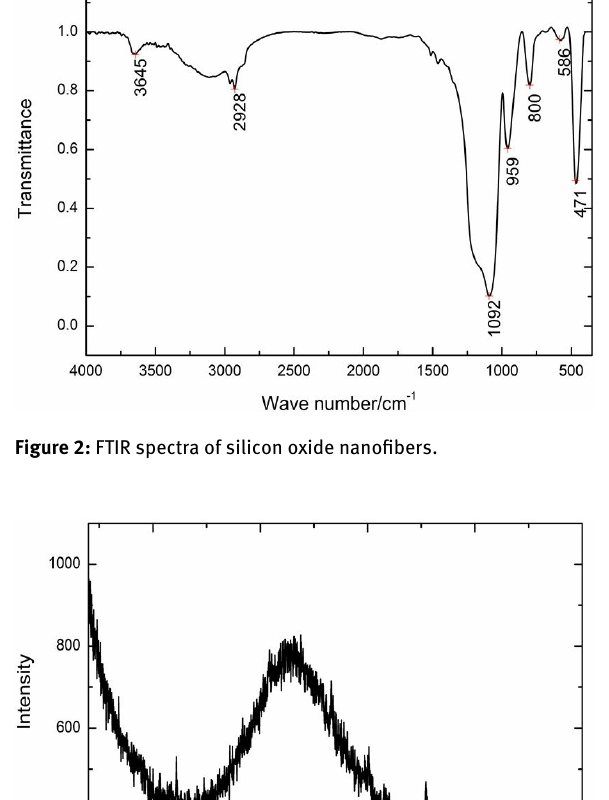
Table 1: Mechanical properties of polyurethane/silicon oxide nano- composite